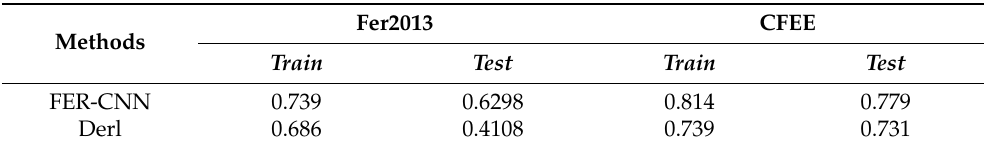
Table 3. Comparison of facial recognition